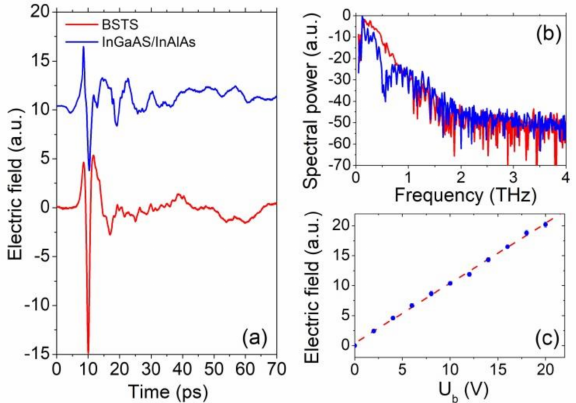
Figure 4. The ( a ) time-domain waveforms of dipole antennas based on BSTS (red) and In- GaAs/InAlAs (blue); ( b ) fast Fourier transform spectra of BSTS (red) and InGaAs/InAlAs (blue) antennas; and ( c ) THz electric field amplitude versus bias voltage for BSTS